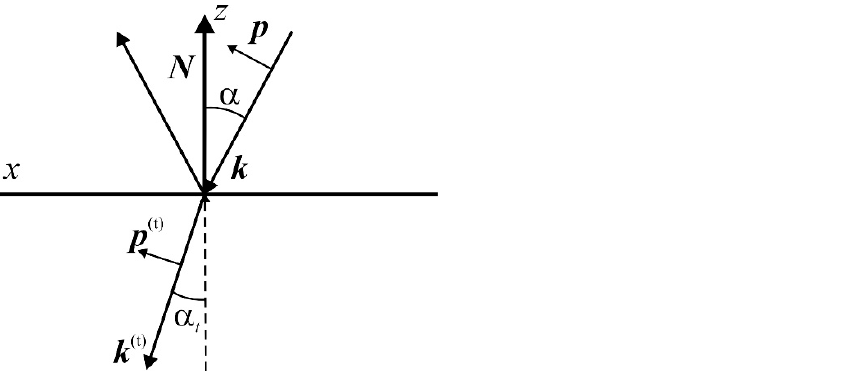
Figure A1. Incidence of the light wave on the interface between isotropic medium and vacuum, α is the angle of the incidence. The electric field of the transversal light wave is perpendicular to the wave vector 𝑲 = (cid:3104) k , where k is the unit vector along the propagation direction. We introduce p - and s -polarizations of the incident and transmitted wave. The s -polarization is oriented perpendicular to the plane of incidence xz .